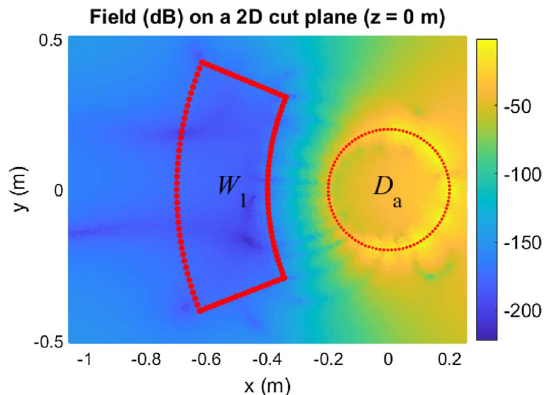
Figure 4. Generated fi eld on the plane z =